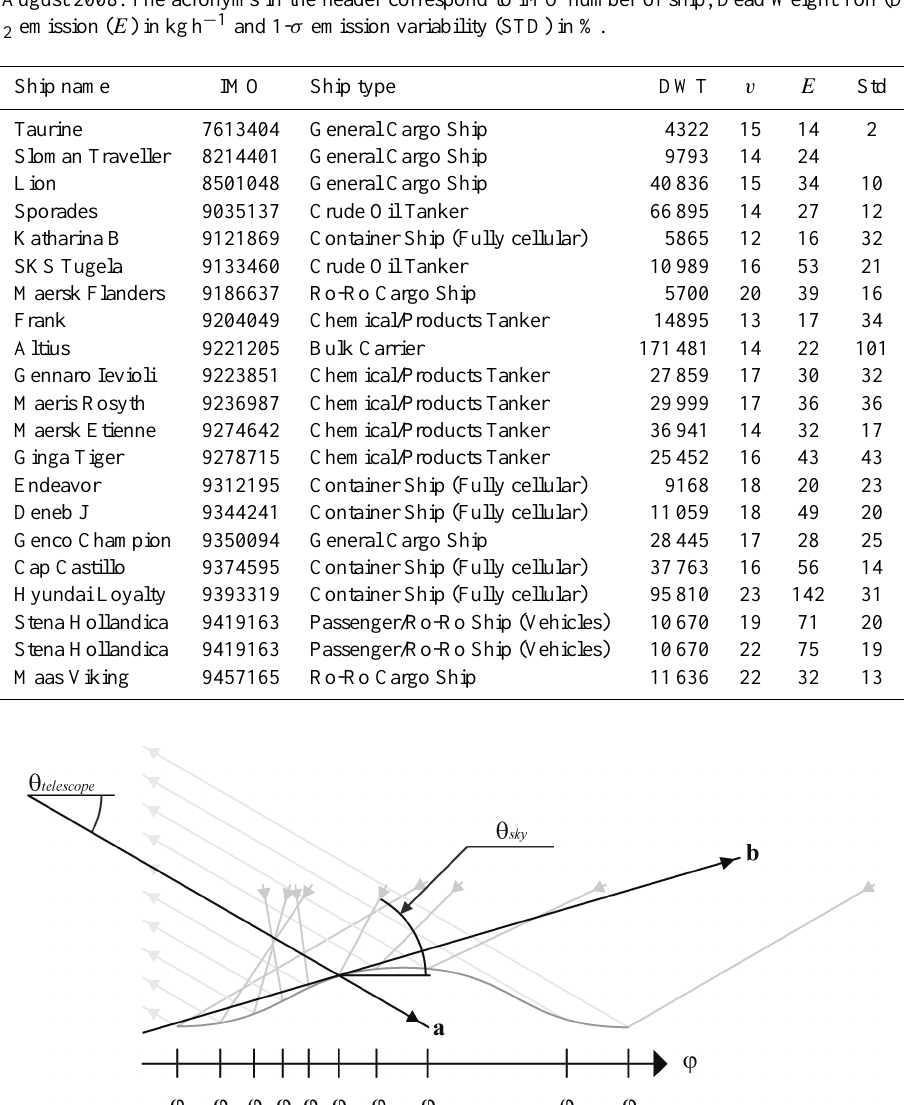
Table 3. Optical NO 2 measurements of ship emission rates performed on the Baltic Sea outside Gotland. The data were obtained on 4 days between 12 and 24 August 2008. The acronyms in the header correspond to IMO number of ship, Dead Weight Ton (DWT), ship speed in